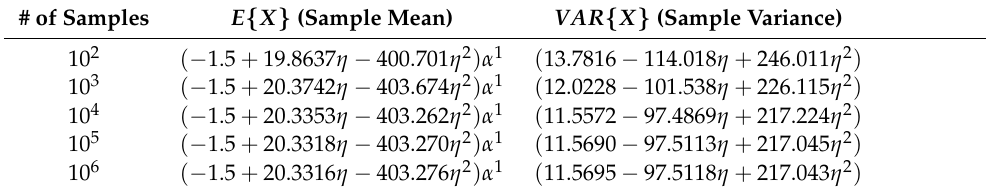
Table 2. Numerical verification for the Euclidean Gaussian having infinite theoretical mean µ = ( − 1.5 + 20.33 η − 403.26 η 2 ) α 1 and finite theoretical variance σ 2 = ( 11.56 − 97.444 η + 217.044 η 2 ) . # of